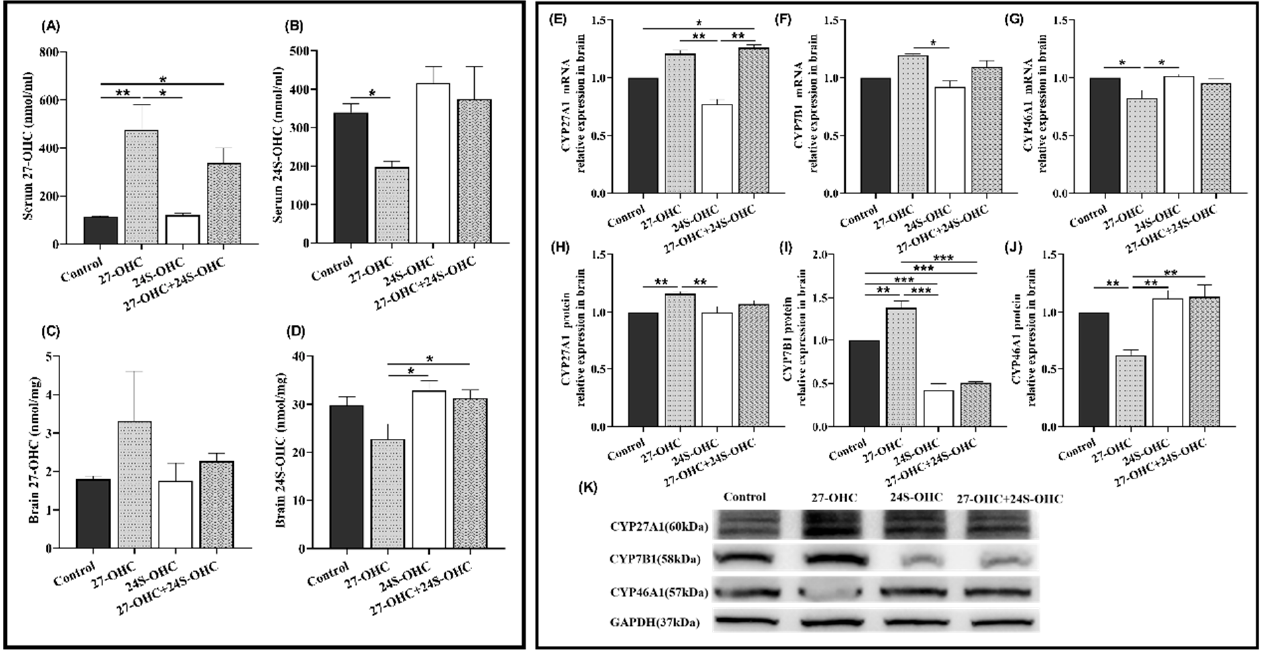
Figure 4. Changes of serum/brain oxysterols and the expression of metabolic enzymes in the brain ( n = 7). ( A ) Serum 27-OHC (median with range); ( B ) serum 24S-OHC (mean ± SEM); ( C ) brain 27-OHC (mean ± SEM); ( D ) brain 24S-OHC (mean ± SEM); ( E ) CYP27A1 mRNA (mean ± SEM); ( F ) CYP7B1 mRNA (median with range); ( G ) CYP46A1 mRNA (mean ± SEM); ( H ) CYP27A1 protein (mean ± SEM); ( I ) CYP7B1 protein (mean ± SEM); (J) CYP46A1 protein (mean ± SEM); ( K ) Western blot results of CYP27A1, CYP7B1 and CYP46A1 *: p < 0.05, **: p < 0.01, ***: p < 0.001.